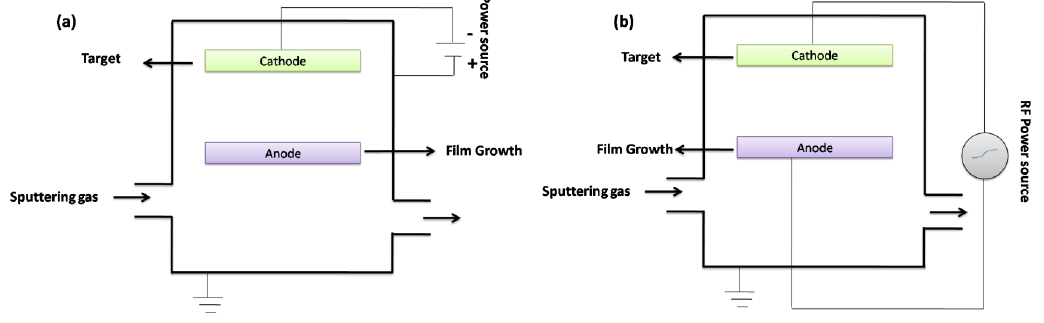
Figure 4. Schematic diagram of the working principle of ( a ) DC and, ( b ) RF magnetron.